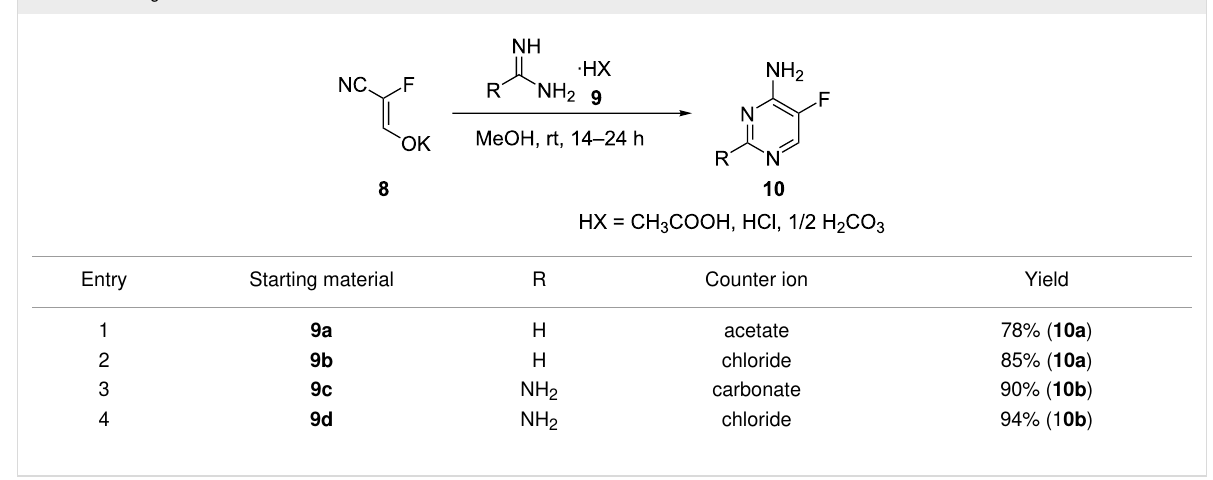
Table 1: Testing of different counter